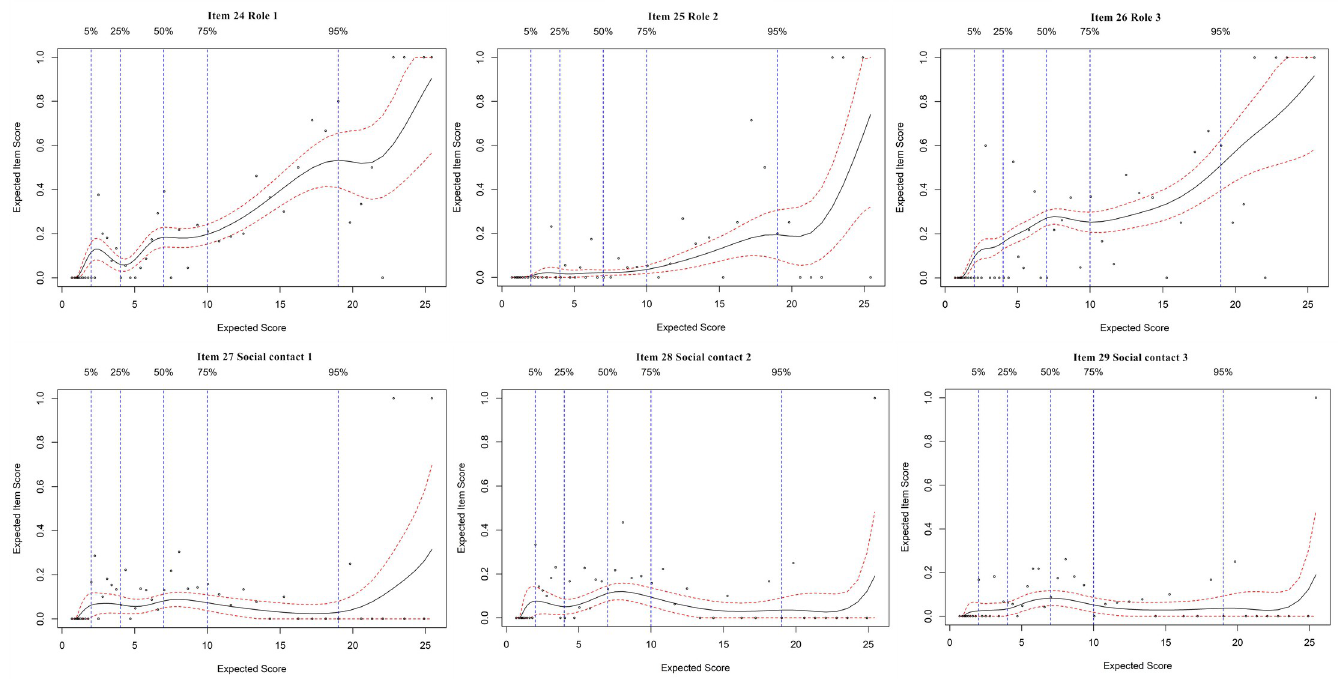
Fig 4. Expected item score curves for social